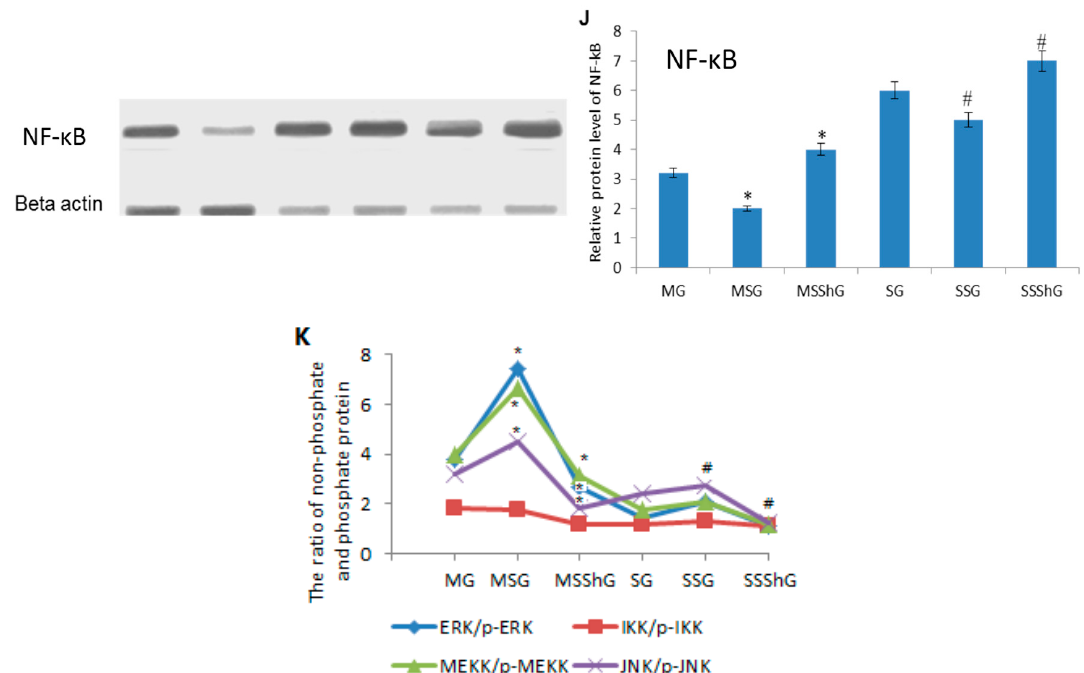
Figure 5. The effects of STC-1 on the protein levels of PKC- α , p-IKK, p-MEKK-1, p-NF- κ B and caspase-3. Among 16 mice, eight mice were used to create RIRI models as a model group and eight mice were used as a sham group. Renal progenitor cells were isolated from the kidney cortex of RIRI model and sham mice after 16-h surgery. For the kidney cells isolated from eight model mice, they were further subdivided into three groups based on different treatment options (model group (MG); STC-1 expression group (MSG), the mice were transfected with STC-1 gene to overexpress STC-1; and STC-1 shRNA group (MSShG), the mice were transfected with STC-1 shRNA to knockdown STC-1). In the same way, the kidney cells from 32 sham mice were subdivided into another three groups based on different treatment options (sham group (SG); STC-1 expression group (SSG), the mice were transfected with STC-1 gene to overexpress STC-1; and STC-1 shRNA group (SSShG), the mice were transfected with STC-1 shRNA to knockdown STC-1). The mRNA levels were measured from the same part of renal tissues obtained after 4-h surgery: ( A ) the changes of protein levels of STC-1 in different groups; ( B ) the changes of protein levels of PKC- α in different groups; ( C ) the changes of protein levels of p-ERK in different groups; ( D ) the changes of protein levels p53 in different groups; ( E ) the changes of protein levels of p-IKK in different groups; ( F ) the changes of protein levels of p-MEKK-1 in different groups; ( G ) the changes of protein levels of p-JNK in different groups; ( H ) the changes of protein levels of ASK-1 in different groups; ( I ) the changes of protein levels of caspase-3 in different groups; ( J ) the changes of protein levels of NF- κ B in different groups; and ( K ) the ratio of non-phosphate proteins and phosphate proteins. All data were normalized to actin, and presented as the mean values ± S.D. * p < 0.05 via model group and # p < 0.05 via sham group.